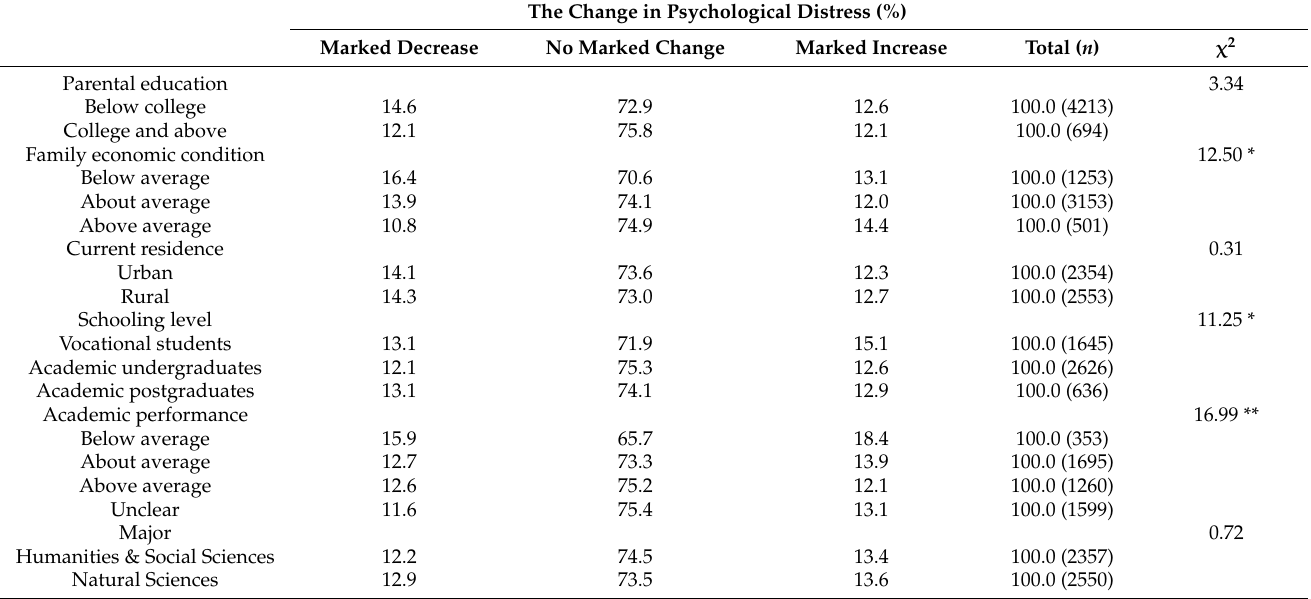
Table 2. Distributions of the individual changes in psychological distress across student